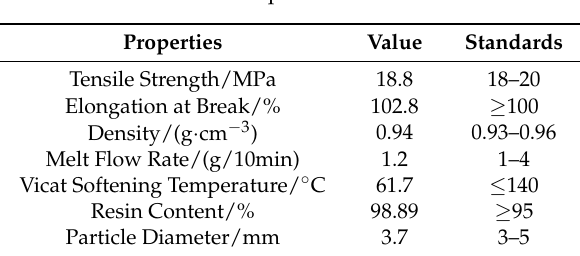
Table 4. Properties of Lubao.